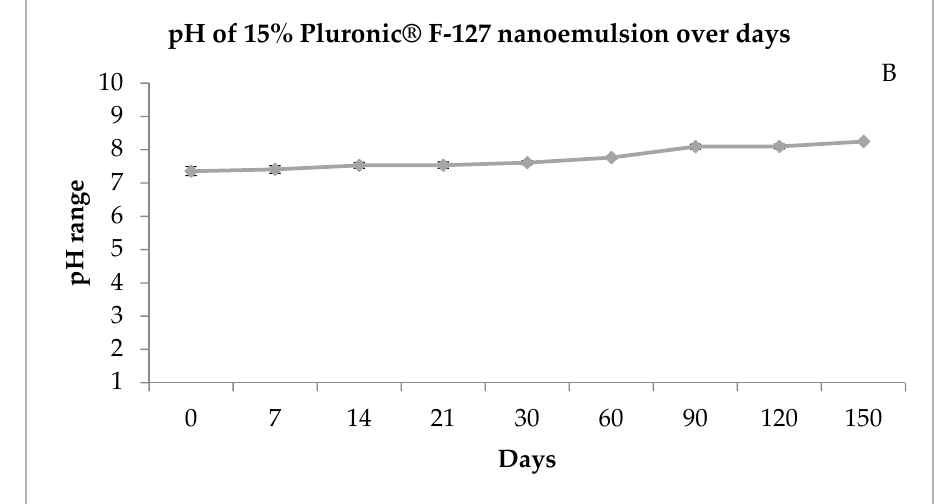
Figure 2. Size distribution of nanoemulsion by number ( A ) and pH of the nanoemulsion prepared with 15% of Pluronic ® F-127 over days ( B ). T = time in days.